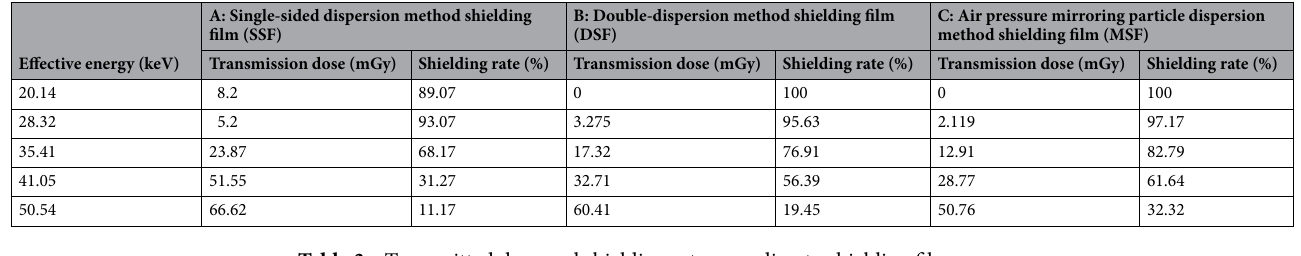
Table 3. Transmitted dose and shielding rate according to shielding film.